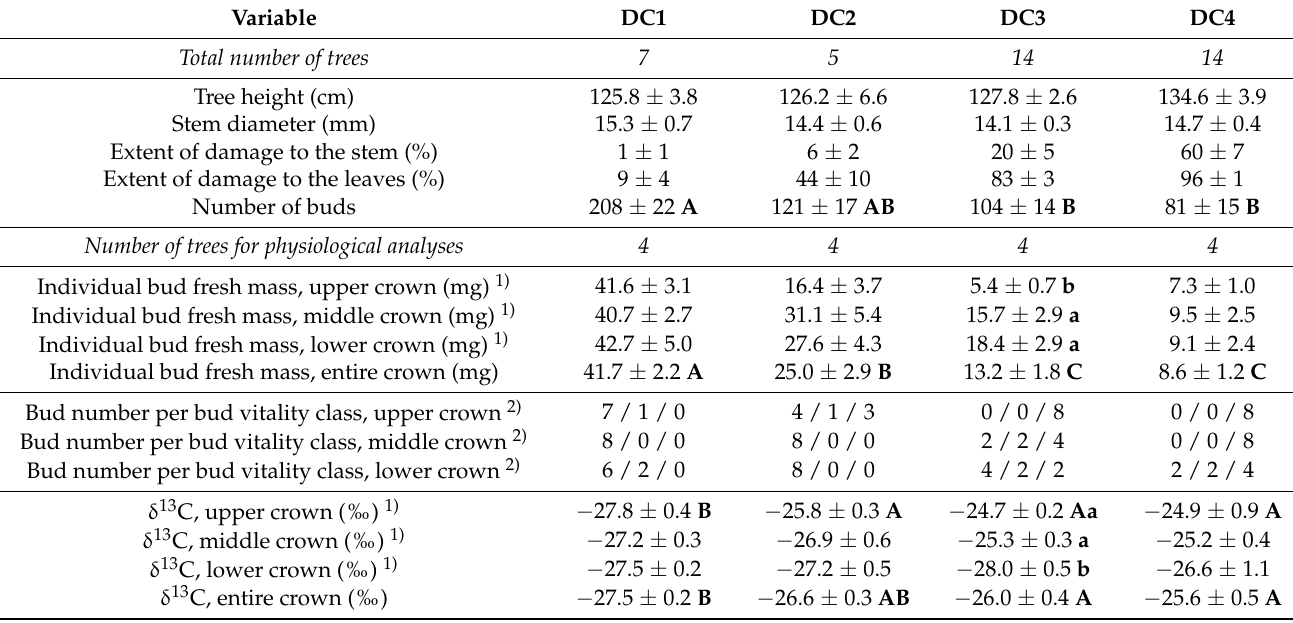
Table 1. Numbers, morphological and physiological variables of young beech trees and buds